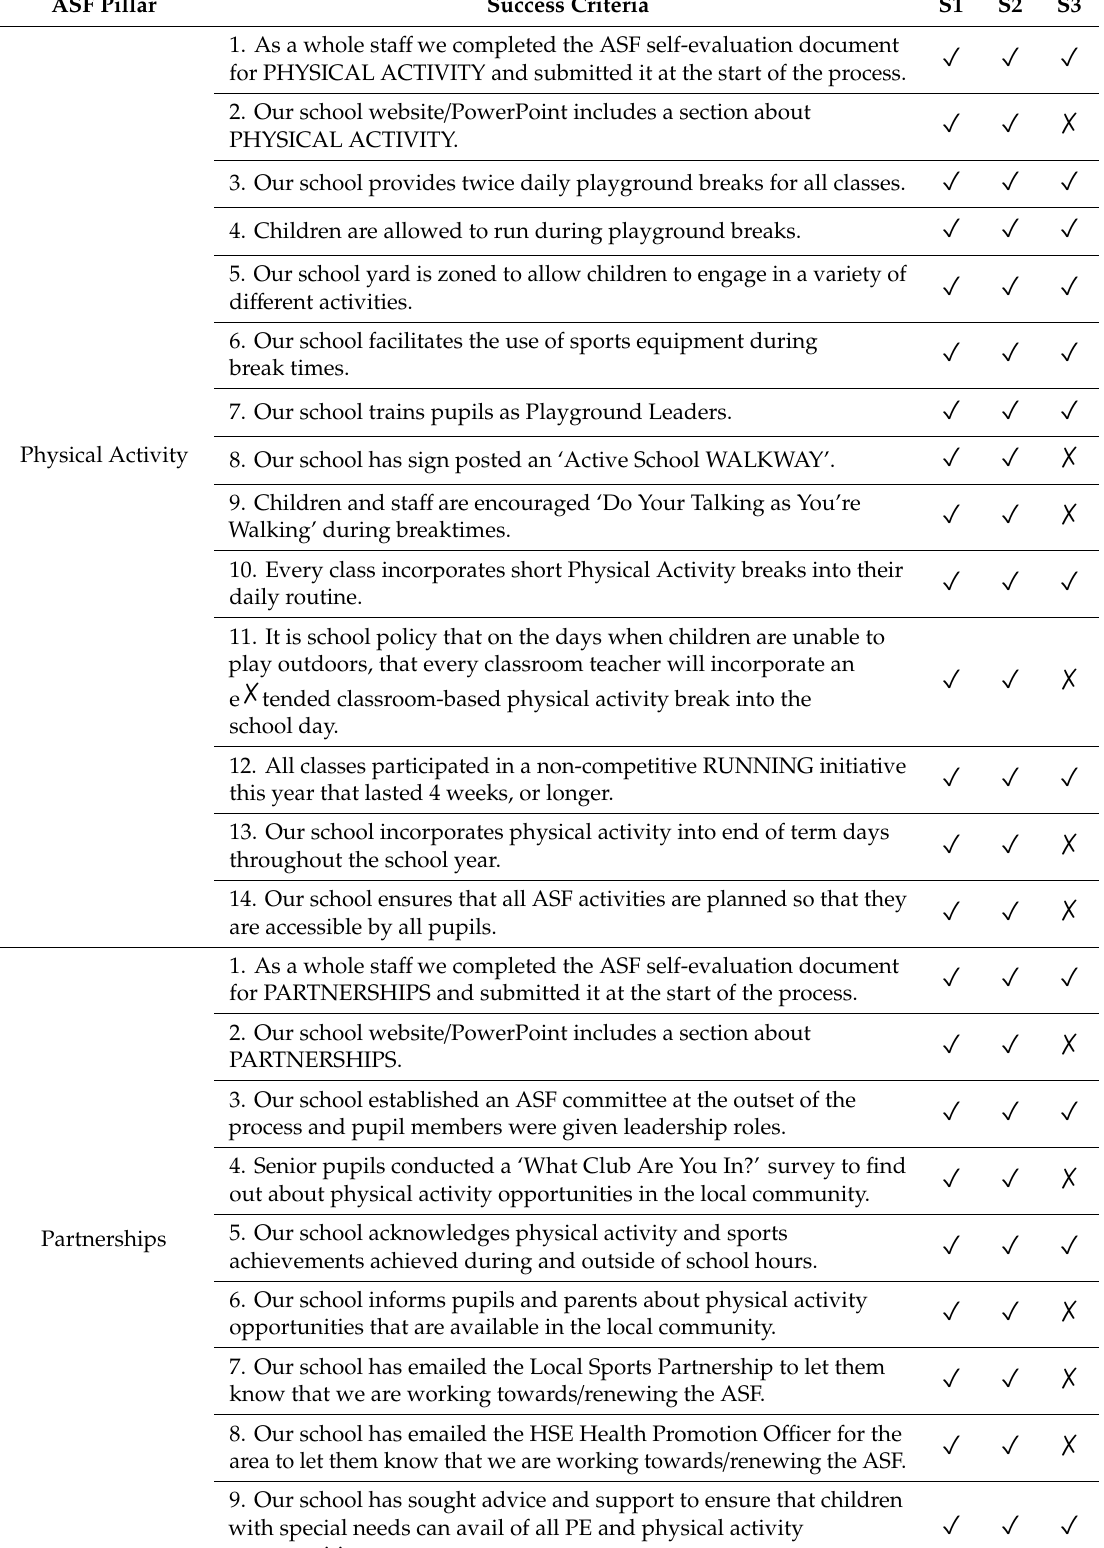
Table 2. ASF success criteria achieved by each case study school.